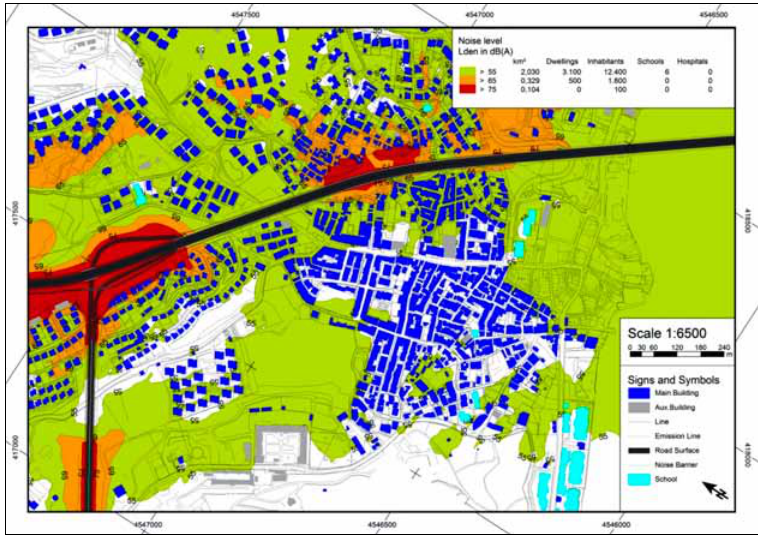
Fig. 7. Statistical noise map for the day-evening-night average (L barriers